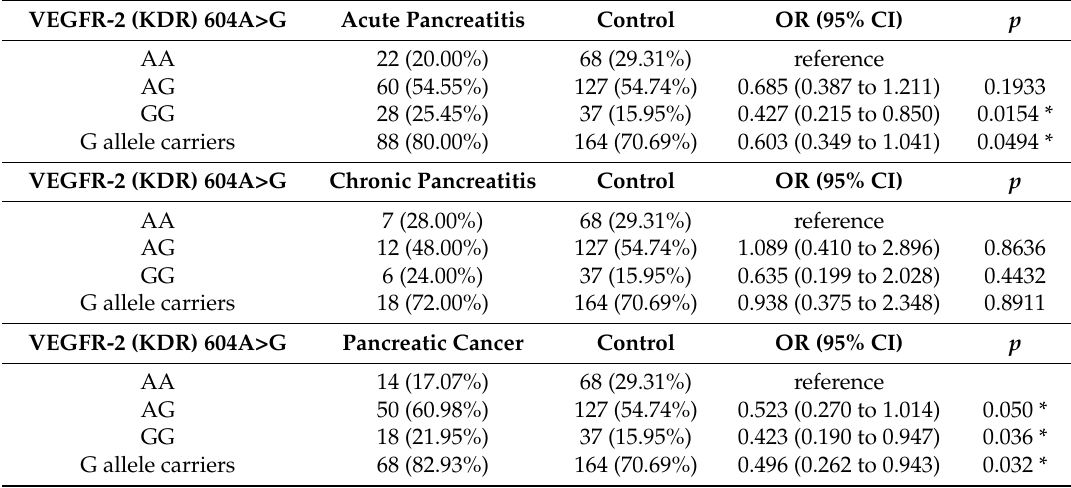
Table 2. Polymorphism of VEGFR-2 (KDR) 604A>G in different pancreatic